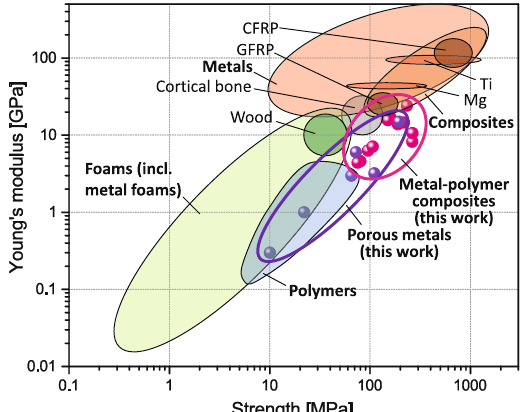
Figure 3. Ashby diagram of Young’s modulus plotted against yield strength demonstrating the unique combination of properties of the metal-polymer composites (Note: CFRP - Carbon-fiber-reinforced polymer, GFRP - glass-fiber reinforced plastic, Mg – magnesium alloys, Ti – titanium